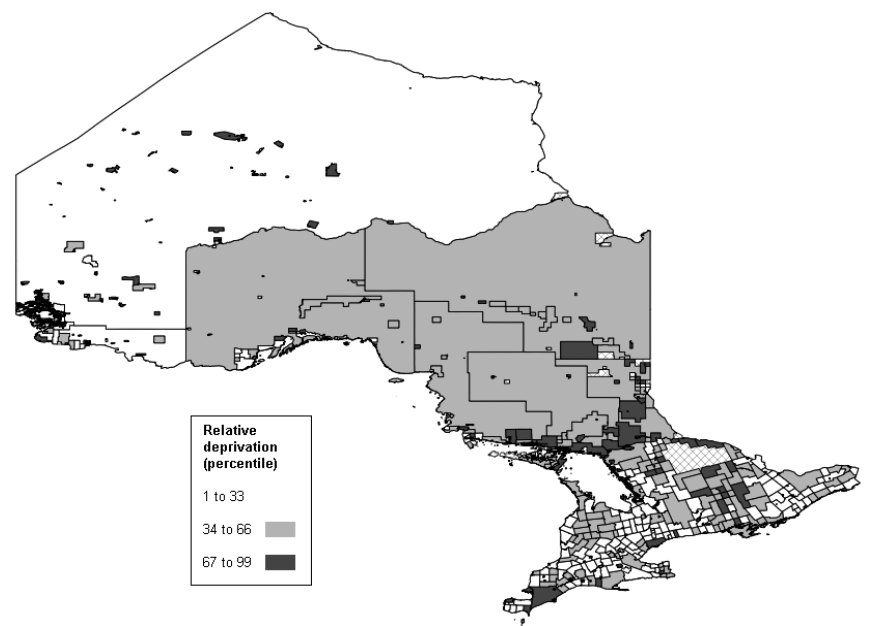
Figure 3. Levels of poverty and social disorganization in